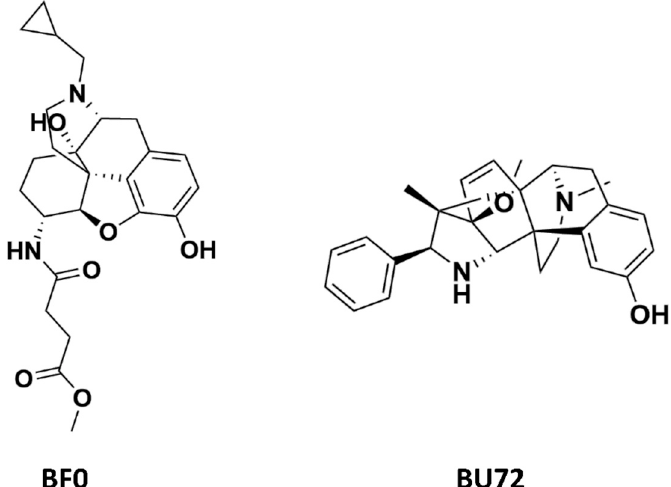
Figure 1. Small molecule ligands co-crystallized with µ opioid receptor crystal structures used in the study.